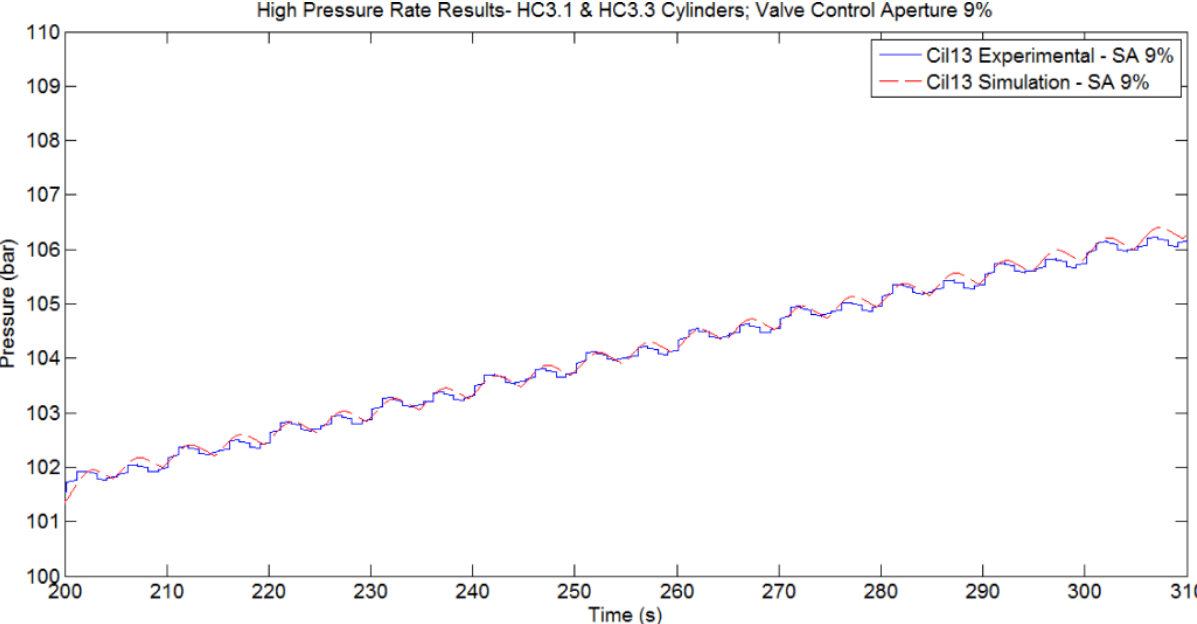
Figure 24. Comparison between Simulated and Experimentally Measured pressure of HP Accumulator. Acitve cylinder HC3.4. Initial Pres. 72 bar. Geometrical layout: Config 1.